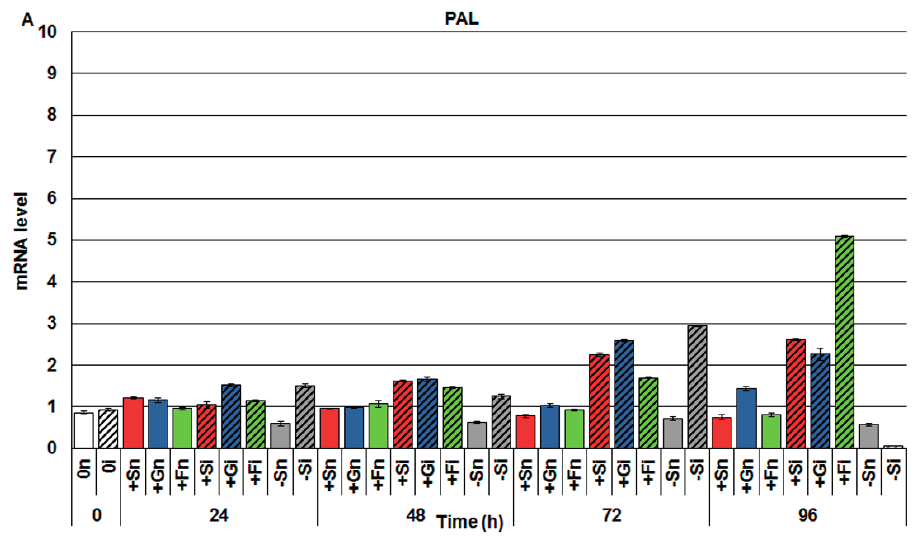
Figure 2. The effect of sucrose, glucose and fructose on expression levels of isoflavone biosynthetic pathway genes, i.e. , phenylalanine ammonia-lyase (PAL) ( A ), chalcone synthase (CHS) ( B ), chalcone isomerase (CHI) ( C ) and isoflavone synthase (IFS) ( D ) in in vitro cultured embryo axes of L. luteus infected with F. oxysporum. Statistical significance of differences between the average values of each pairs for expression levels of isoflavone biosynthetic pathway genes. Statistically significant differences ( p -value) was assumed at p <